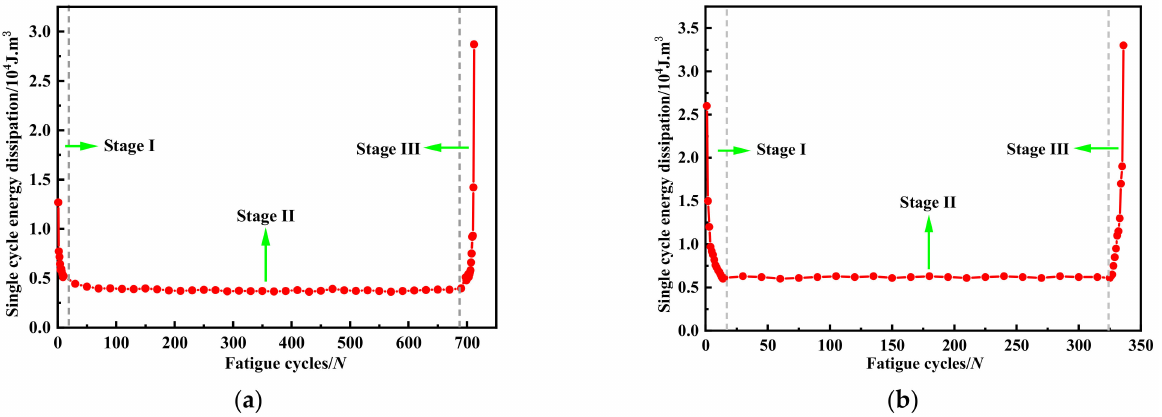
Figure 16. Evolution law of dissipative energy during the whole process of fatigue loading. ( a ) F2-1; ( b )